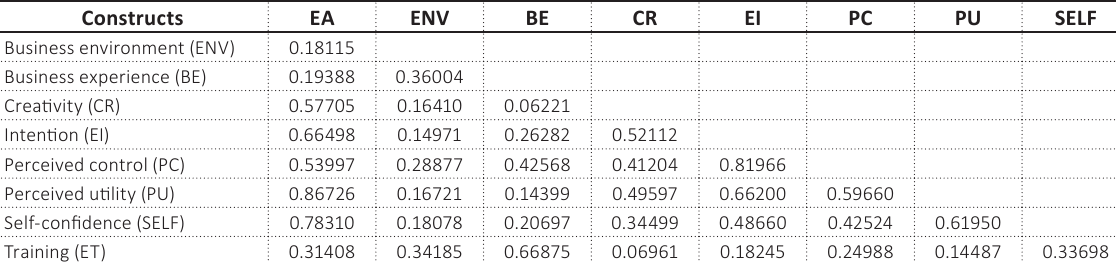
Table A7. Heterotrait-Monotrait Ratio